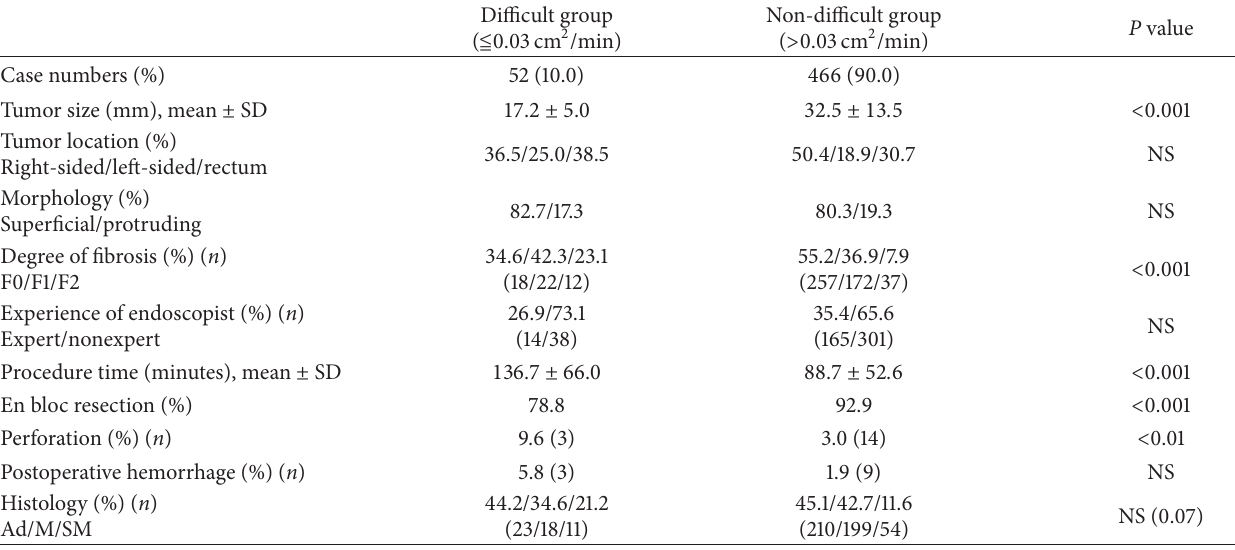
Table 3: Clinical outcomes of difficult and non-difficult groups in view of procedure speed.